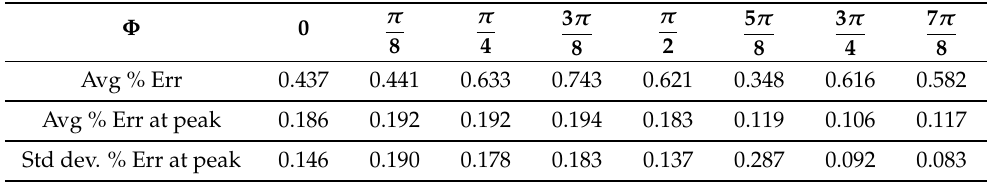
Figure 12. Legend for Figure 11. Table 10. Percent Error for CS reconstruction for each Φ for R = 1 AU. The second row shows average % error over all time samples, the third row shows average % error at the peak of each curve, and the last row shows the standard deviation of the % error at the